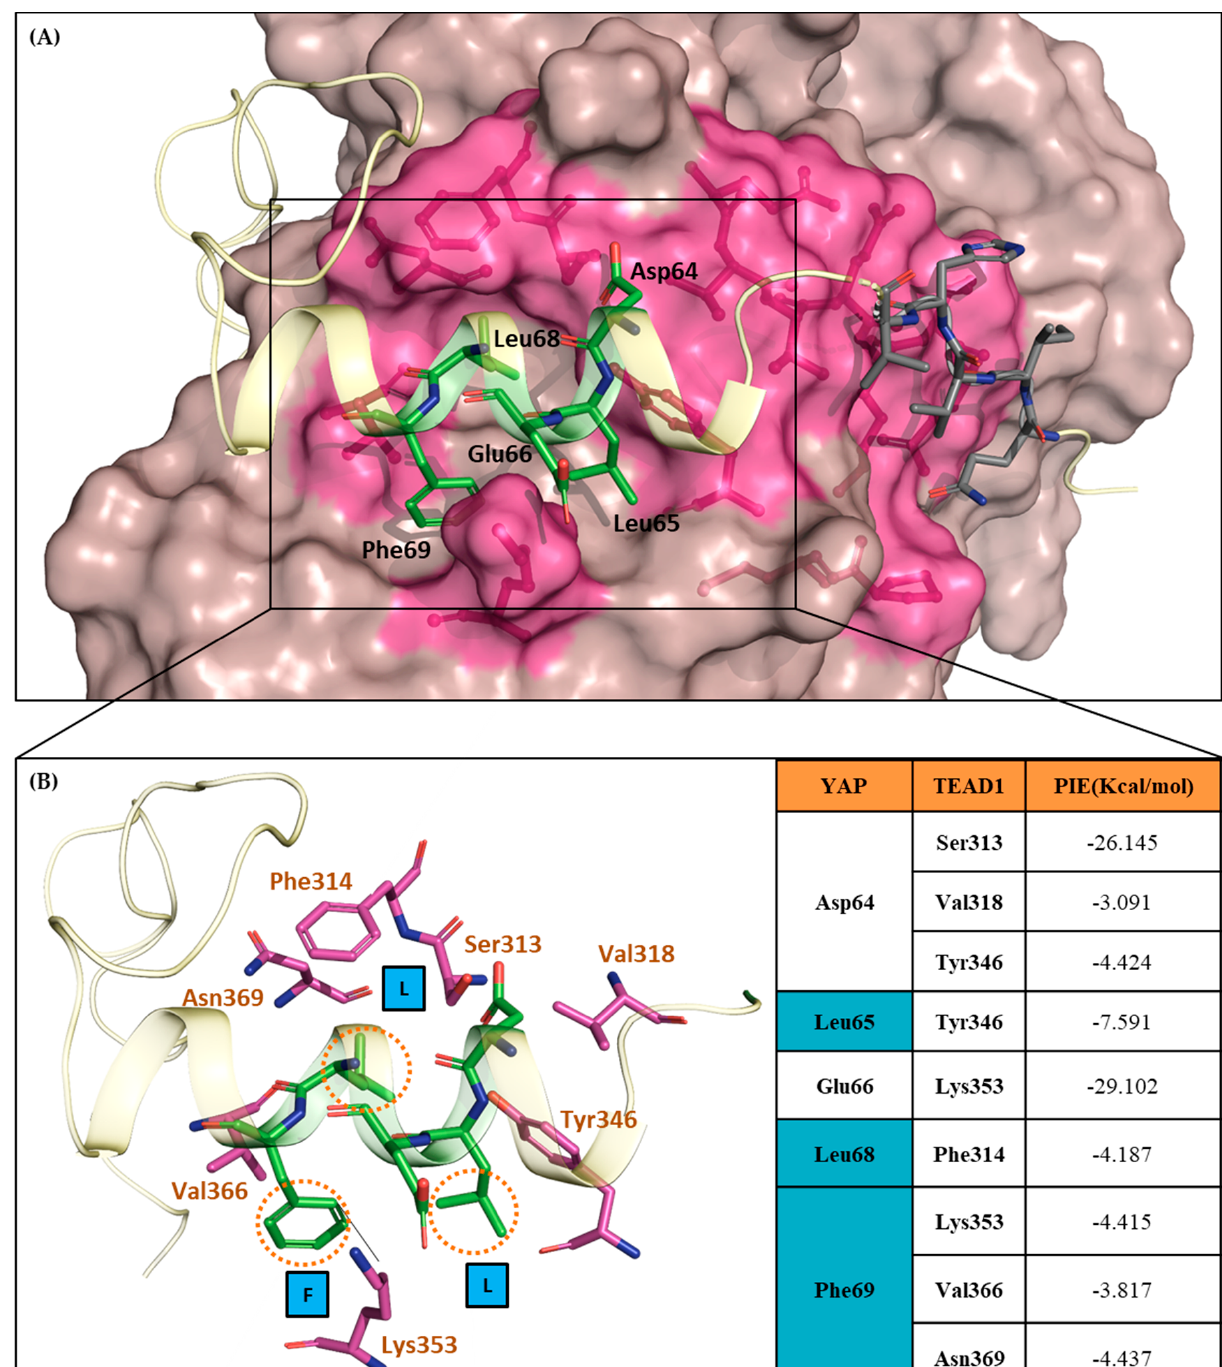
Figure 2. FMO analysis for interface 2 of YAP–TEAD1 PPIs. ( A ) Hot spot residues of YAP, namely, Asp64, Leu65, Glu66, Leu68, and Phe69, in interface 2 are shown as green sticks, Yellow indicates YAP alpha-helix and dark pink TEAD, and Raspberry color represents the TEAD1 interaction domain for YAP hot spot residues in interface 2. ( B ) TEAD1 hot spot residues, namely, Ser313, Val318, Tyr346, Lys353, Phe314, Val366, and Asn369, are shown as magenta sticks. The blue box indicates the LxxLF hydrophobic motif in YAP. The detailed PIEs are described in the right panel.